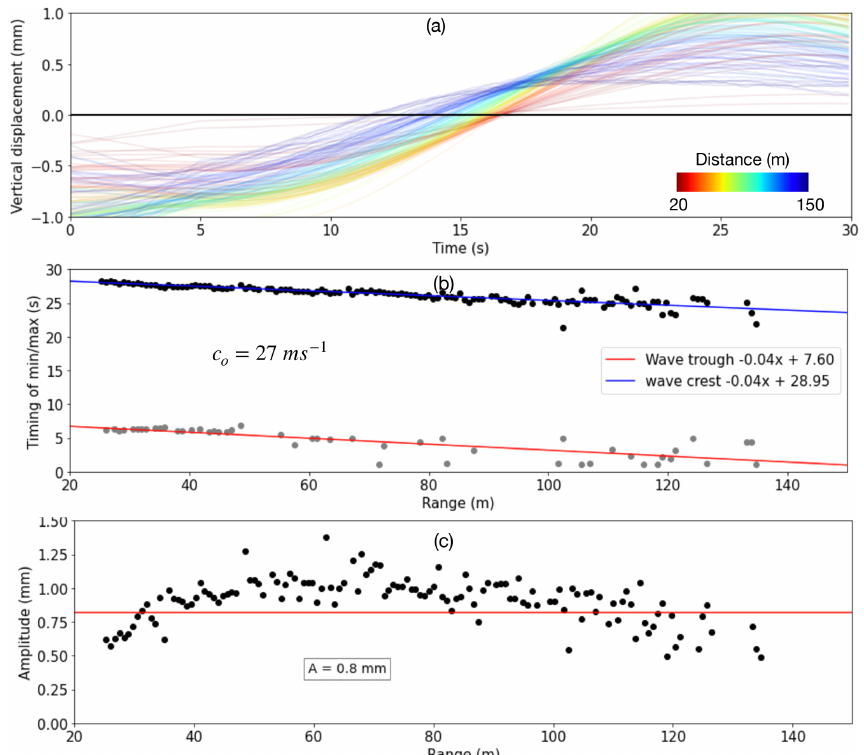
Figure 9. (a) Derived vertical displacement over 30s on 24 April 2021 at 00:44UTC (E2). Each line represents one location on the ice, where warmer colors signify a distance closer to the radar. (b) Exact time of the wave crest and troughs at different distances from the radar. The linear fit indicates a wave velocity of 27ms − 1 and period of 43s. (c) Amplitude with